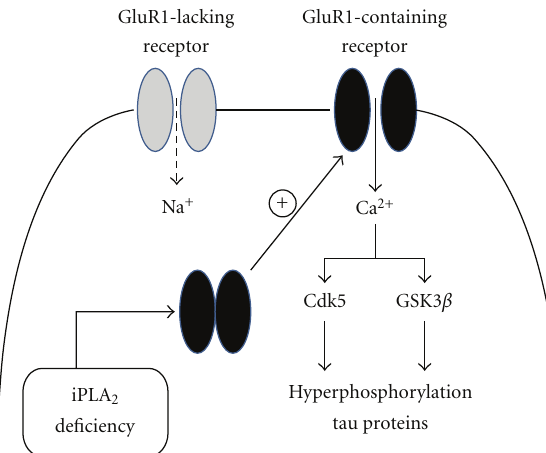
Figure 3: A putative model illustrating the potential implication of iPLA 2 γ in Alzheimer’s disease. In this simplified model, iPLA 2 dysfunction leads to excessive delivery of GluR1-containing recep- tors to neuronal membranes. These receptors are more likely to be calcium-permeable and therefore to stimulate calcium influx and, eventually, Tau phosphorylation by calcium-dependent protein kinases such as Cdk5 and GSK-3 β